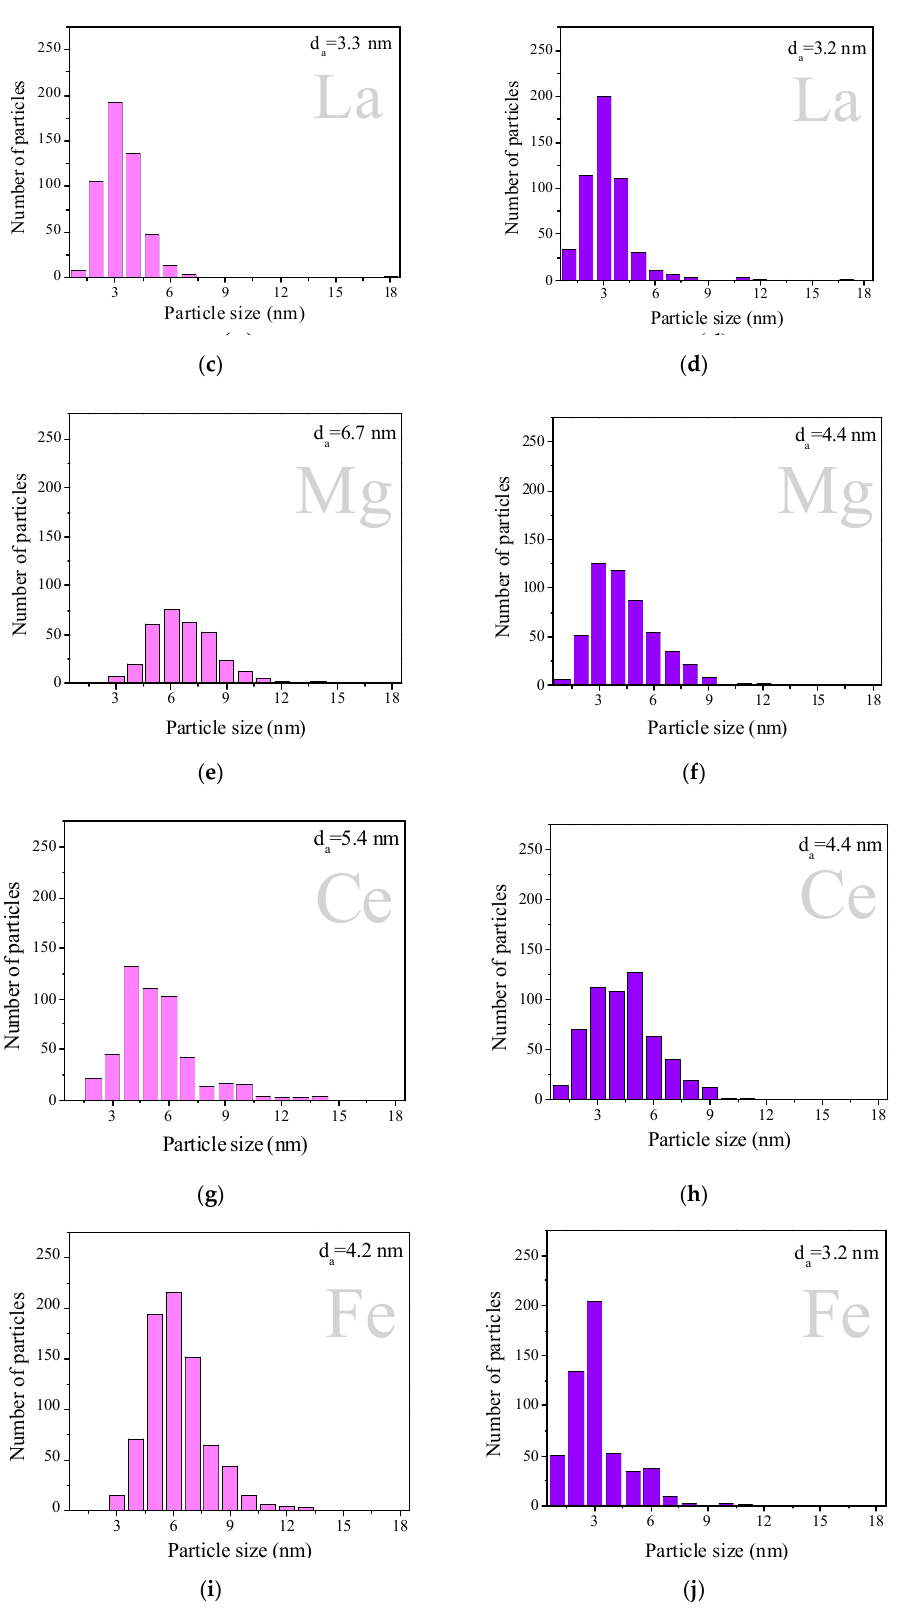
Figure 2. Particles size distribution of AuAg (pink) and AgAu (purple) catalysts on different supports: TiO 2 ( a , b ), La/TiO 2 ( c , d ), Mg/TiO 2 ( e , f ), Ce/TiO 2 ( g , h ) and Fe/TiO 2 ( i , j ). Samples were studied after reduction in H 2 at 300 °C for 1 h. Some previously reported results concerning AuAg samples are included for comparison, reprinted from [44] (copyright 2017), with permission from EUREKA SCIENCE.